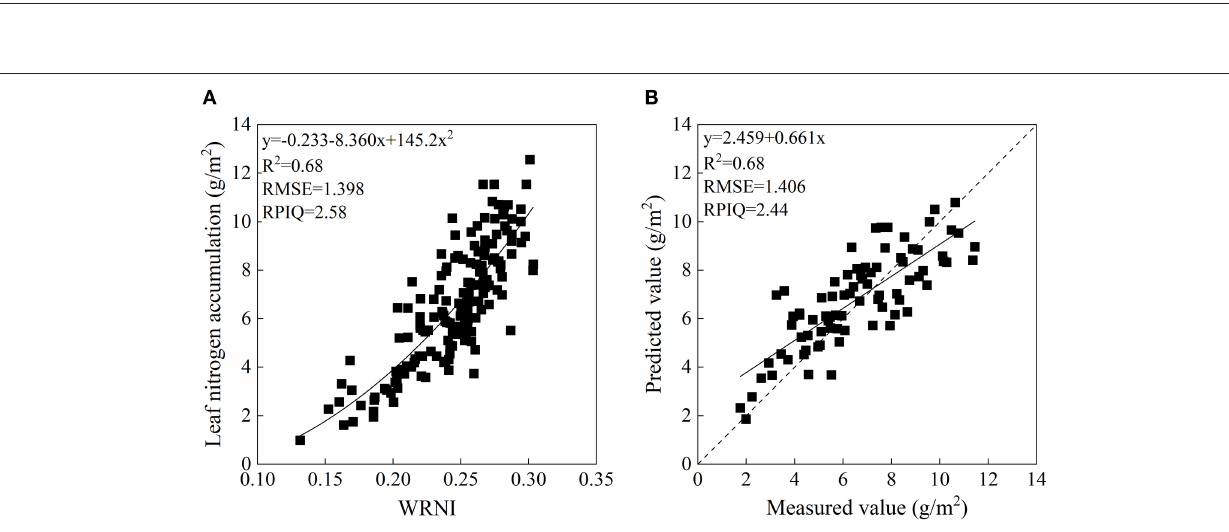
Frontiers in Plant Science | www.frontiersin.org